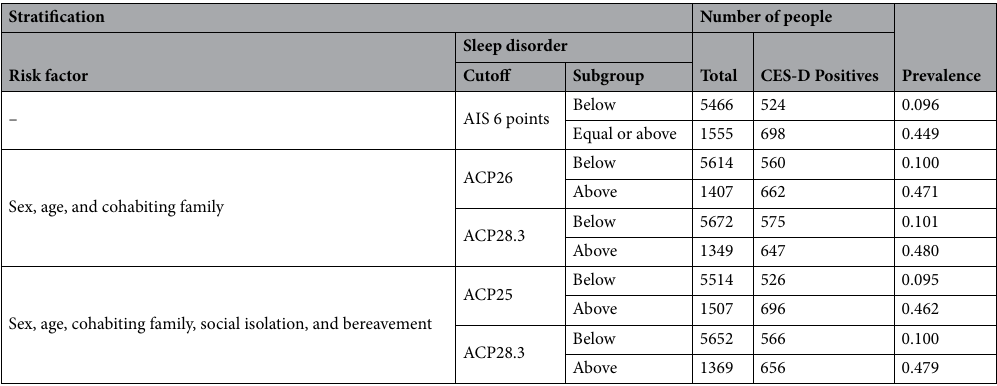
Table 3. Prevalence of Center for Epidemiologic Studies Depression positivity in each category divided by sleep disorder cutoff.